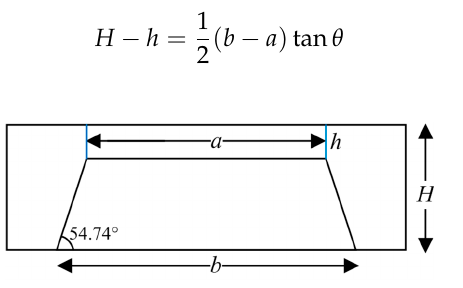
Figure 2. Schematic diagram of silicon cup structure of single MEMS pressure sensor.